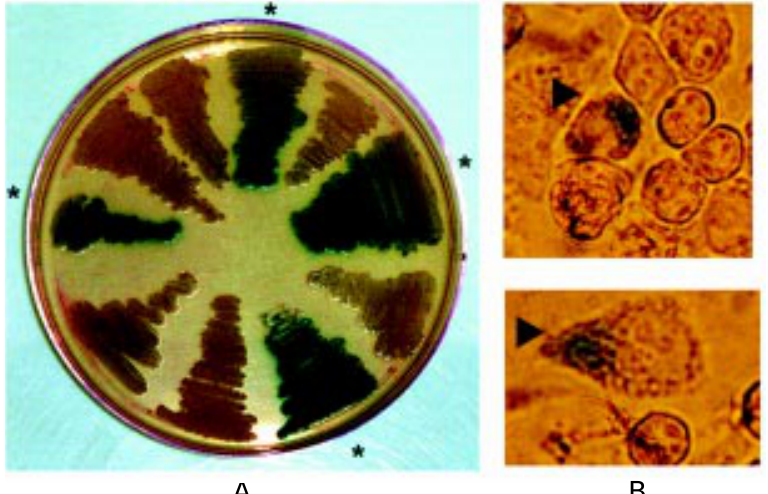
Figure 4 - Expression of ß-galactosidase in recombinant M. smegmatis . A , 7H10-OADC- kanamycin-X-gal agar plates. M. smegmatis mc 2 155 transformed with pJEM12 containing the insert in correct orientation is indicated by asterisks. B , J774 macrophages infected with M. smegmatis transformed with pJEM harboring the insert in correct orientation. Arrowsheads show cells with a blue precipitate indicative of ß-galactosidase